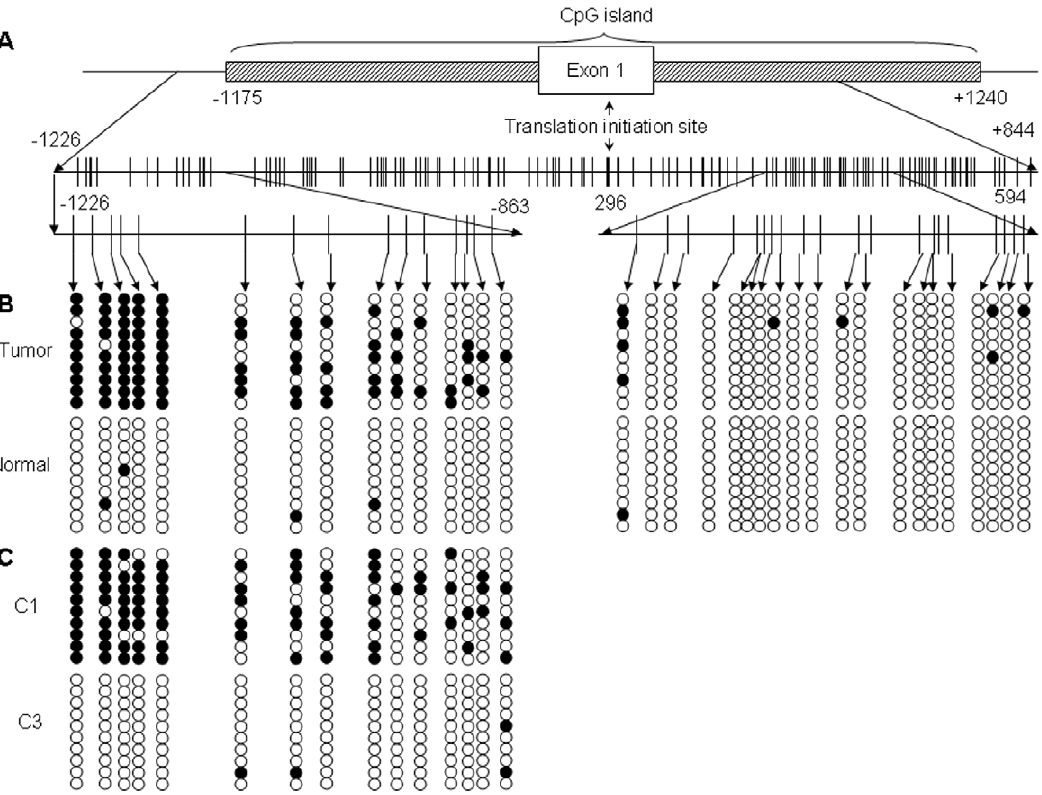
Figure 1. Hypermethylation of Nrf2 promoter in TRAMP prostate was correlated with tumorigenesis. ( A ) A CpG island was identified in the 5 9 -flanking region of mouse Nrf2 gene, spanning from position 2 1175 to + 1240 with the translation initiation site set as position 1. The sequences covered by bisulfite genomic sequencing ( 2 1226 to + 844) and contain methylated CpGs are schematically presented with CpG sites indicated by vertical lines. ( B ) The methylation patterns and extents of CpG sites in the promoter of Nrf2 gene in TRAMP prostate tumor and apparently normal prostate were determined by bisulfite genomic sequencing as described in Material & Methods. Black dots indicate methylated CpGs and open circles indicate non-methylated CpGs. ( C ) The methylation patterns and extents of CpG sites in the promoter of Nrf2 gene in TRAMP C1 and C3 cells were determined. The CpGs in the sequence between + 296 to + 594 are not displayed because methylation is insignificant.